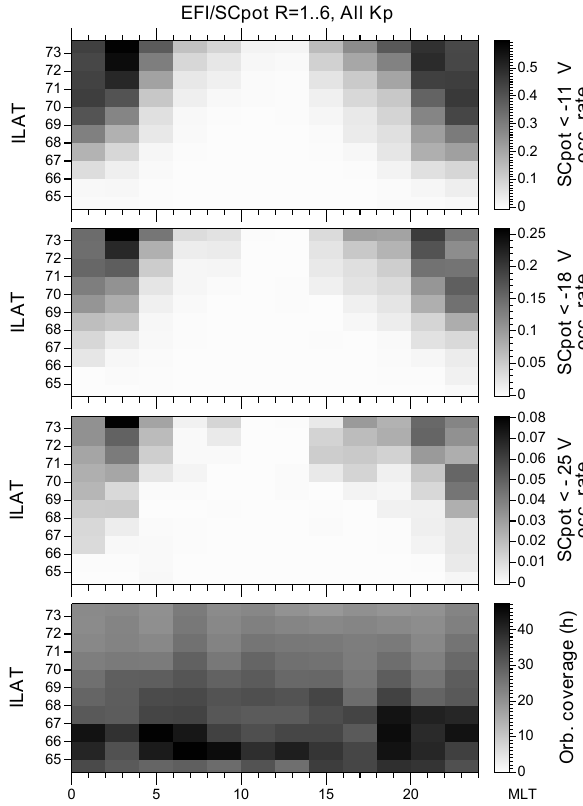
Fig. 3. Occurrence frequency of cavities for three different thresh- olds as a function of MLT and ILAT. The lowest panel shows the orbital